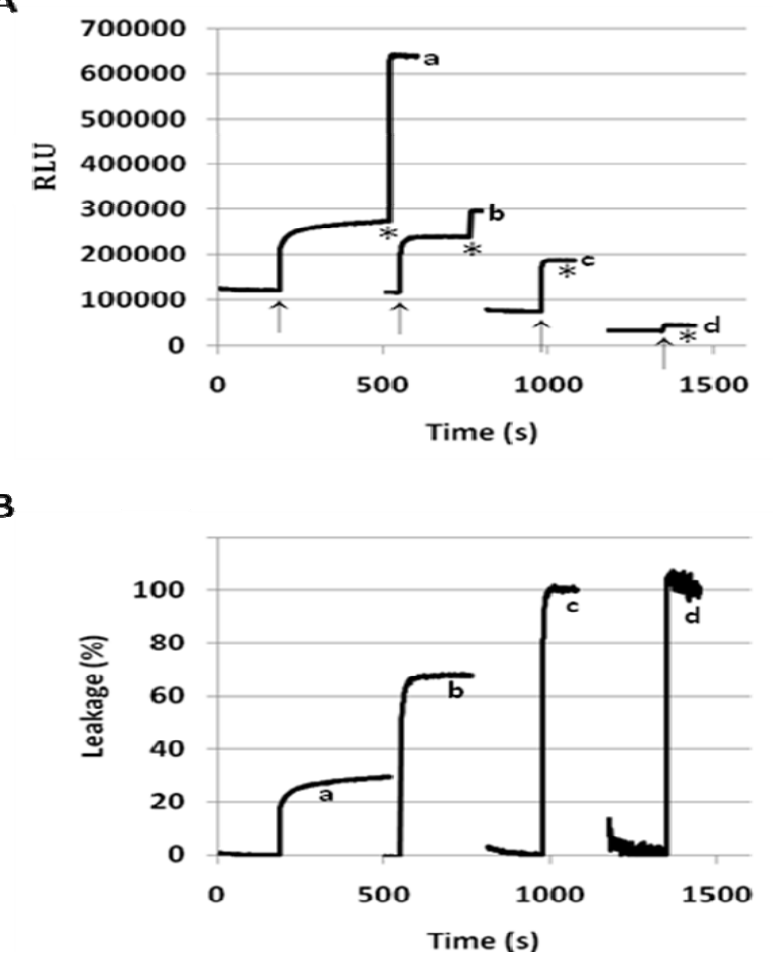
Figure 3. Effect of the mole percentage of 1 on the pH-triggered release of ANTS from 1 /POPC/PEG-ceramide fliposomes. The release is presented: ( A ) in relative light units (RLU) and ( B ) in percent of leakage. The molar ratio 1 /POPC/PEG-ceramide: a, 25/70/5; b, 50/45/5; c, 75/20/5; d, 90/5/5. Arrows indicate addition of acid to lower pH from 7.4 to 5.1; E for fliposomes permeation. The x -axes are in relative asterisks indicate addition of C 12 8 time scales to fit all the traces into the